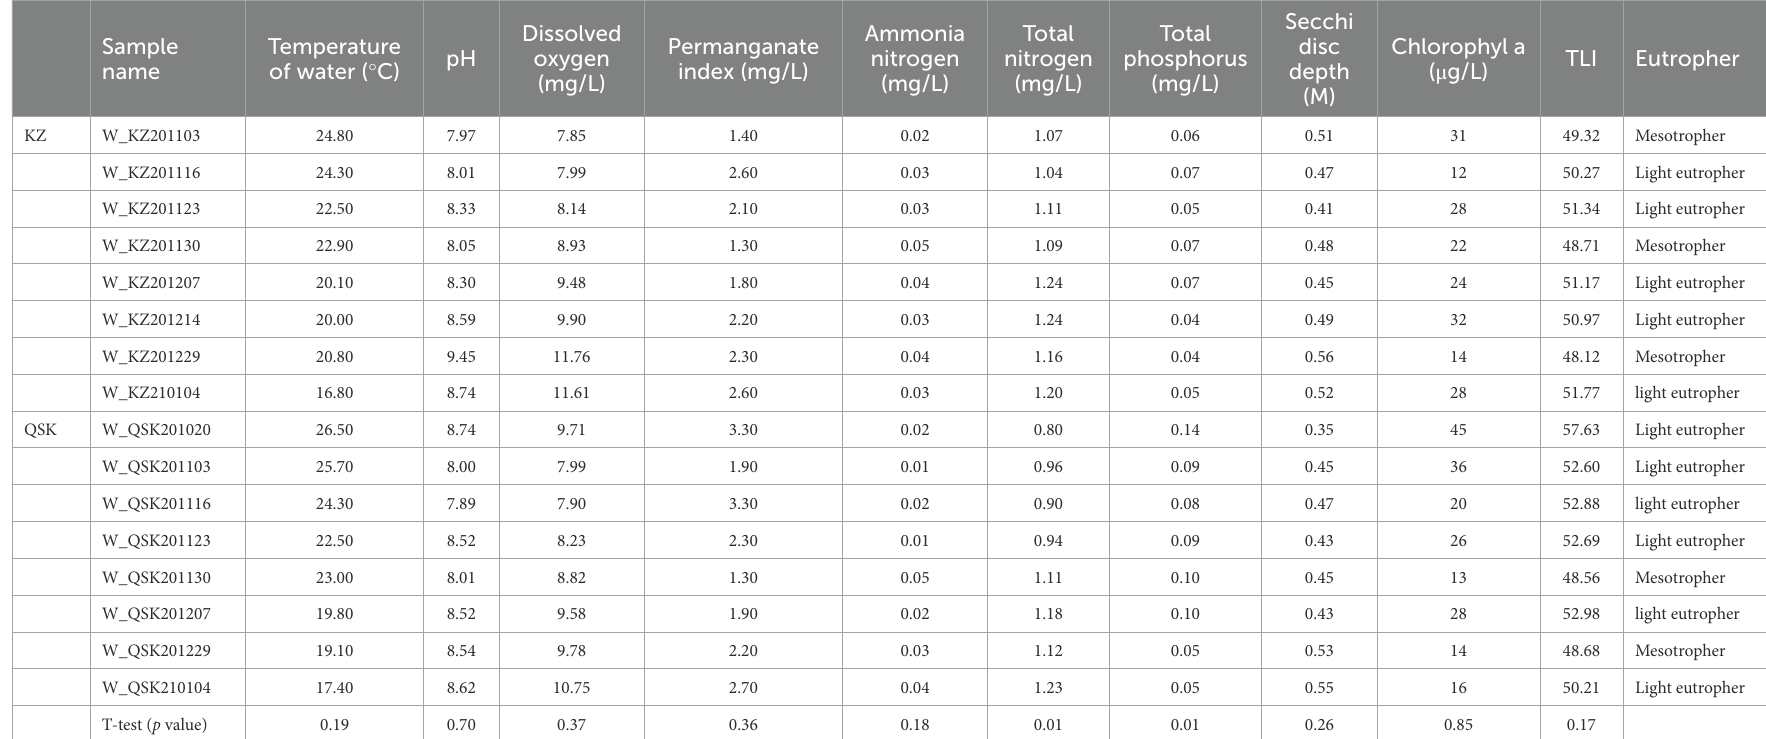
TABLE 1 Value of environmental variables measured in the samples of